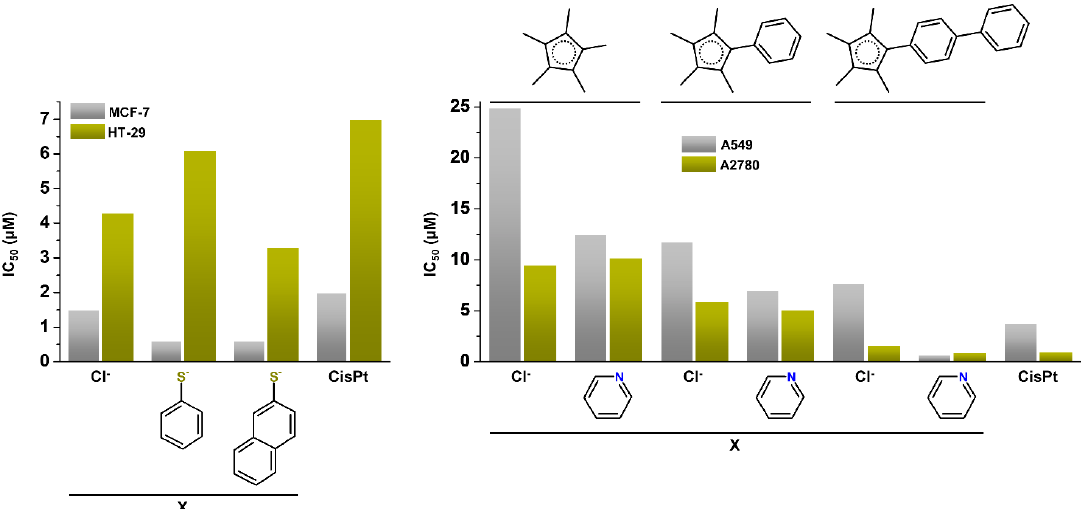
Figure 13. Comparison of in vitro antiproliferative activity of complexes [Rh( η 5 -Cp*)(dppz)X]CF 3 SO 3 ( left ; X = Cl – , ben- zenethiolate or naphthalene-2-thiolate) against the MCF-7 breast carcinoma and HT-29 colon carcinoma cell lines, and complexes [Rh( η 5 -Cp x )(bqui)X]NO 3 ( right ; X = Cl – or pyridine) against the A549 lung carcinoma and A2780 ovarian carcinoma cell lines. dppz = dipyrido[3,2- a :2 ′ ,3 ′ - c ]phenazine, Hbqui = benzo[ h ]quinolone, Cp x = pentamethylcyclopentadiene (HCp*), (2,3,4,5-tetramethylcyclopenta-2,4-dien-1-yl)benzene (HCp ph ) or 4-(2,3,4,5-tetramethylcyclopenta-2,4-dien-1-yl)biphenyl (HCp bph ), CisPt = cisplatin. Complexes [Rh( η 5 -Cp*)(pta)(hq)]CF 3 SO 3 (Figure 7 and Table 2) and